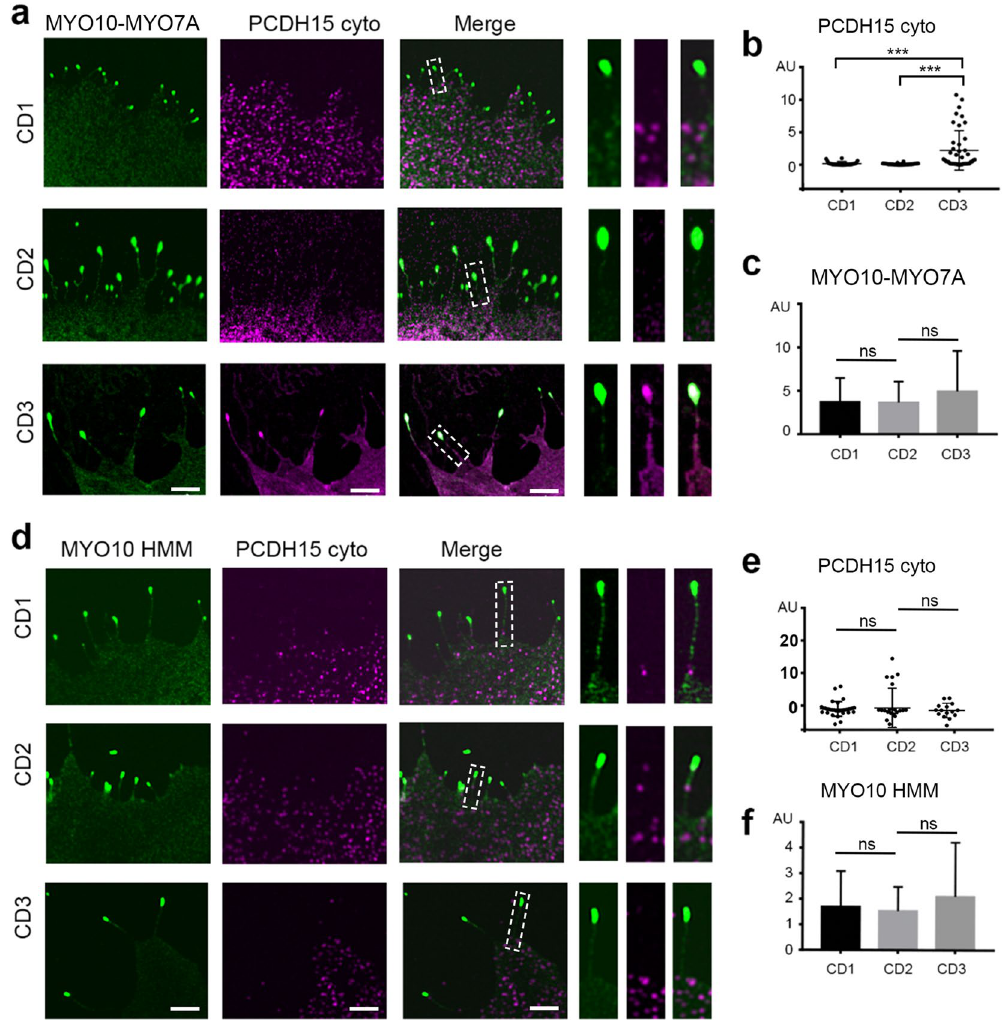
Figure 4. MYO7A tail enables transport of PCDH15-CD3 to the tips of filopodia. ( a ) Confocal images of COS7 cells expressing the chimeric MYO10-MYO7A protein (green) and cyto PCDH15-CD1, -CD2 or -CD3 (magenta). The right panels show a close-up view of a representative filopodia. ( b ) PCDH15-CD3 cyto exhibits significantly higher tip-to-shaft ratio than PCDH15-CD1 or PCDH15-CD2 when co-expressed with MYO10- MYO7A. ( c ) MYO10-MYO7A exhibit a similar enrichment at the filopodia tips when co-transfected with FL PCDH15-CD1, -CD2 or -CD3. ( d ) Confocal images of COS7 cells expressing the MYO10 (green) and cyto PCDH15-CD1, -CD2 or -CD3 (magenta). The right panels show a close-up view of a representative filopodia. ( e ) We did not observe a significantly change in the tip-to-shaft ratio of any of the PCDH5 isoform tested. ( f ) MYO10 HMM exhibited a similar enrichment at the filopodia tips when co-transfected with FL PCDH15-CD1, -CD2 or -CD3. Each dot in b and e represents one filopodia. Number of filopodia n = 15–43. One-way ANOVA analysis was performed with Dunnett’s multiple comparisons test. Level of significance was determined based on the p value (n.s p > 0.05, *p < 0.05, **p < 0.01, ***p < 0.001, ****p < 0.0001). Scale bar = 2